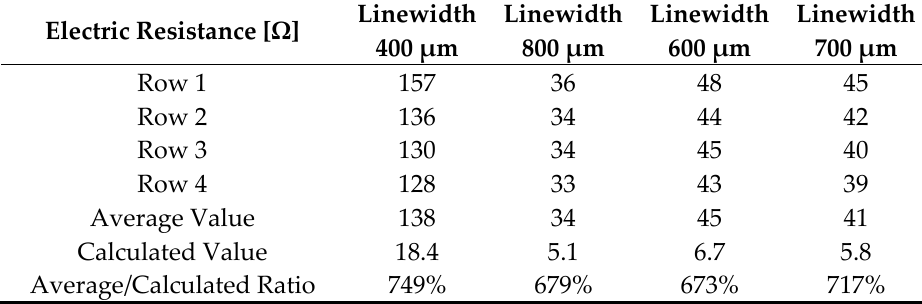
Table 2. Resistance of the Cu film heater due to linewidth of heater pattern.